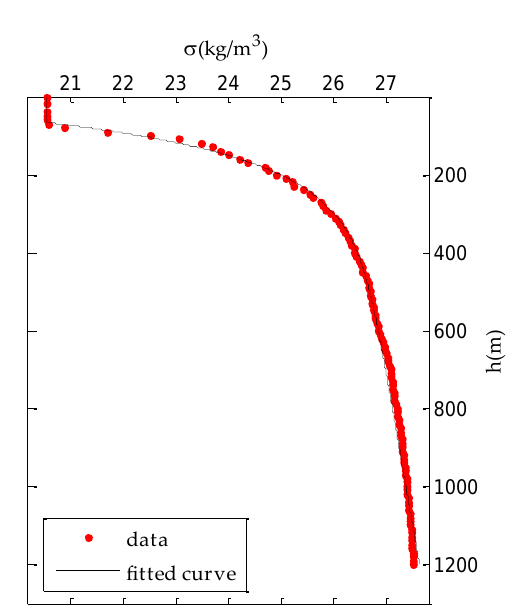
Figure 4. Seawater density fitting curves vary with depth at a point of South China Sea.